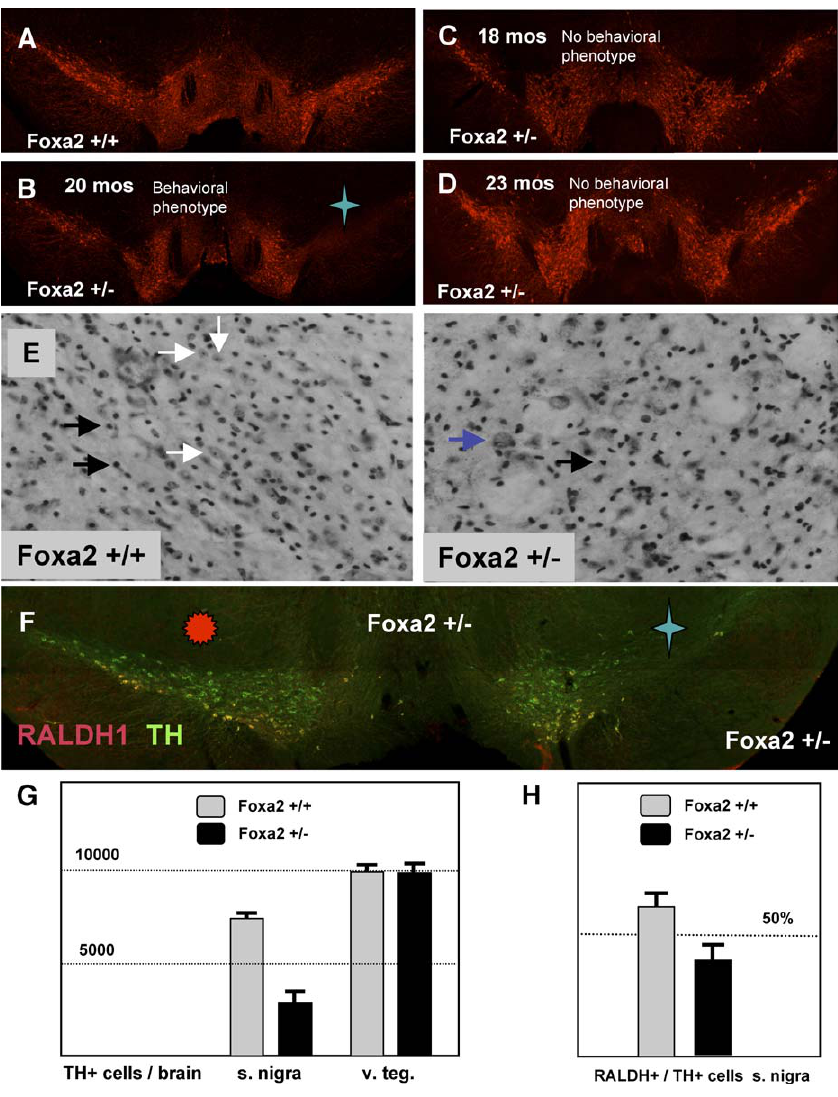
Figure 4. Dopamine Neuron Loss in foxa2 þ / (cid:2) Mice (A and B) Dopamine neurons in a 24-mo-old wild-type mouse (A) and a foxa2 þ / (cid:2) littermate (B). The mouse in (B) possessed a kinked posture and the other late-onset motor phenotypes. A significant loss of nigral dopamine neurons is easily observed on one side of the brain marked by a blue star in the foxa2 þ / (cid:2) mouse. (C and D) TH staining of the the ventral midbrain in older foxa2 þ / (cid:2) animals without late onset behavioral abnormalities. Note that the dopaminergic system resembles the wild-type condition seen in (A). (E) Nissl staining of wild-type and foxa2 þ / (cid:2) mutant mice. Representative glia and neurons are highlighted with white and black arrows, respectively. Note the significant loss of normal neuronal morphologies in the mutant animal. Occasionally, a dysmorphic cell, highlighted here with a purple arrow, can be seen in the mutant, but not the wild-type brain. (F) Ventral tier dopamine neurons, stained for RALDH1 (red), are selectively lost in foxa2 þ / (cid:2) animals. In this animal, nigral dopamine neurons are almost completely lost on the left side (marked by the blue star), whereas the right side (marked by the red sun) is much less affected (note that these are coronal sections, presented as if the animal were facing the viewer, so that the left side of the animal is on the viewer’s right side. (G) Quantitation of dopamine neurons in the SN and VTA of wild-type ( n ¼ 3) and foxa2 þ / (cid:2) ( n ¼ 3) mice. The number of dopamine neurons in the mutant SN (2,765.0 6 750.5) is substantially smaller than in the control SN (7,344.3 6 197.9). In contrast, the number of the dopamine neurons in the VTA is roughly the same in wild-type (9,922.0 6 375.7) and mutant mice (10,064.7 6 355.4). (H) The percentage of RALDH1-expressing neurons in the SN is reduced in foxa2 þ / (cid:2) mutants as compared to wild-type controls.